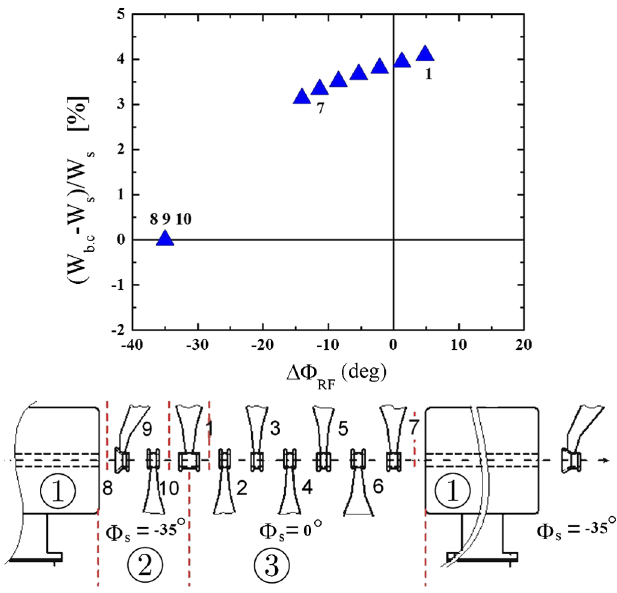
FIG. 4. The motion of the bunch center in the phase space in a typical KONUS